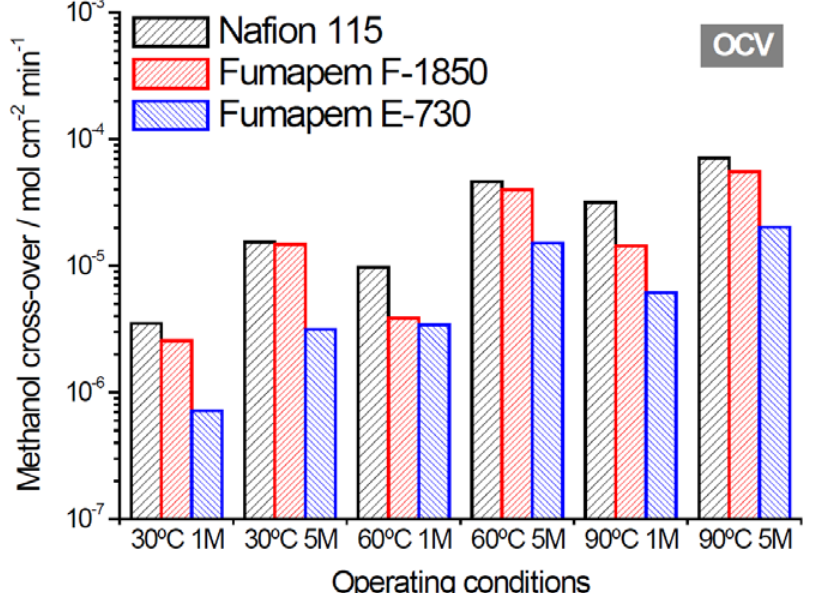
Figure 1. Methanol crossover for selected membranes under different operating conditions of temperature and methanol concentration; crossover was here determined at open circuit voltage (OCV) during normal DMFC operation by measuring the CO 2 evolved at the cathode using an in-line chromatograph.